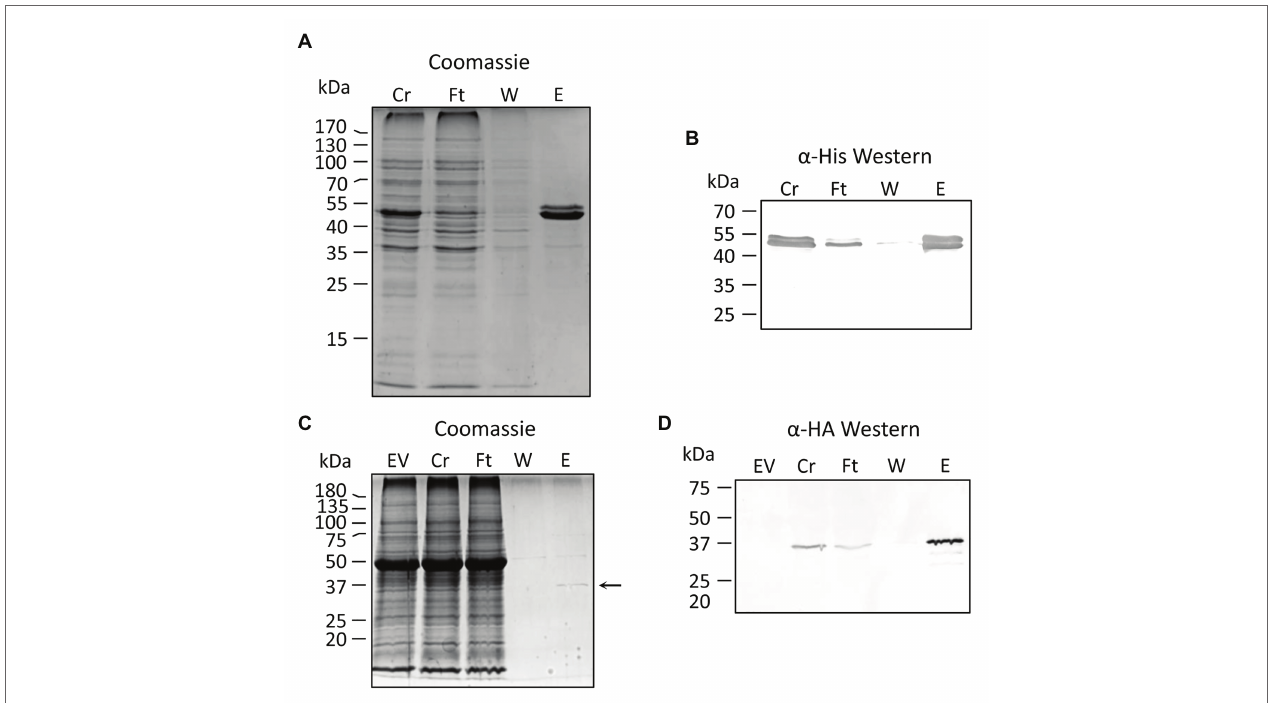
FIGURE 2 | Purification of recombinant PvNSH1 and PvNSH2. (A,B) Purification of His-tagged PvNSH1 overexpressed in Escherichia coli (A) Colloidal Coomassie stained and (B) Western blot. (C,D) Purification of Strep-tagged PvNSH2 overexpressed in Nicotiana benthamiana leaves (C) Colloidal Coomassie stained and (D) Western blot. The arrow points at the protein band representing PvNSH2. Cr, Crude extract; Ft, flowthrough; W, wash; E, elution, and EV, empty vector.